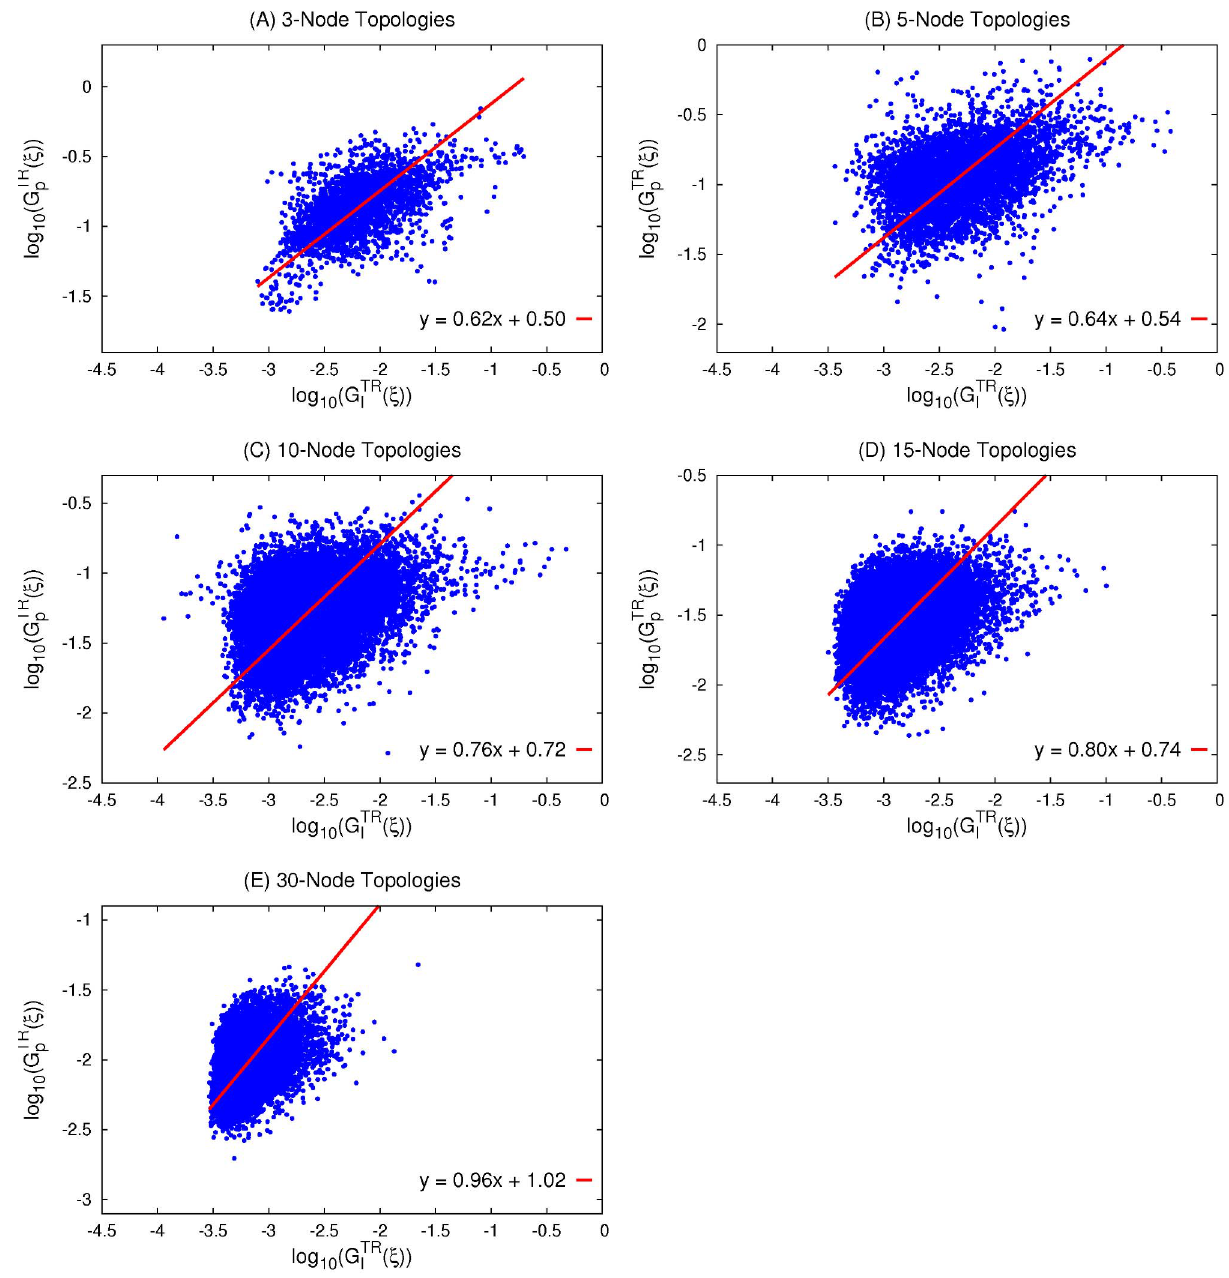
Figure 3. Correlation between robustness to input and parameter perturbations within 3-node, 5-node, 15-node, and 30-node TR (cid:2) (cid:3) j ð Þ (cid:4) (cid:5) and log 10 G TR j ð Þ are measures of robustness of a topology j to input and parameter perturbations, respectively, networks. log 10 G TR I p computed from the average over TR networks. Topologies with a low fraction of TR networks (less than 2.3%) are not included. The linear regression for all sizes (3-node, 5-node, 15-node, and 30-node) shows a significant (p , 0.0001) correlation between log 10 G TR topologies: slope=0.62 ( N =2445, r=0.57). (B) 5-node topologies: slope=0.64 ( N =7847, r=0.40). (C) 10-node topologies: slope=0.76 ( N =18300, r=0.33). (D) 15-node topologies: slope=0.80 ( N =19264, r=0.35). (E) 30-node topologies: slope=0.96 ( N =16587, r=0.41).